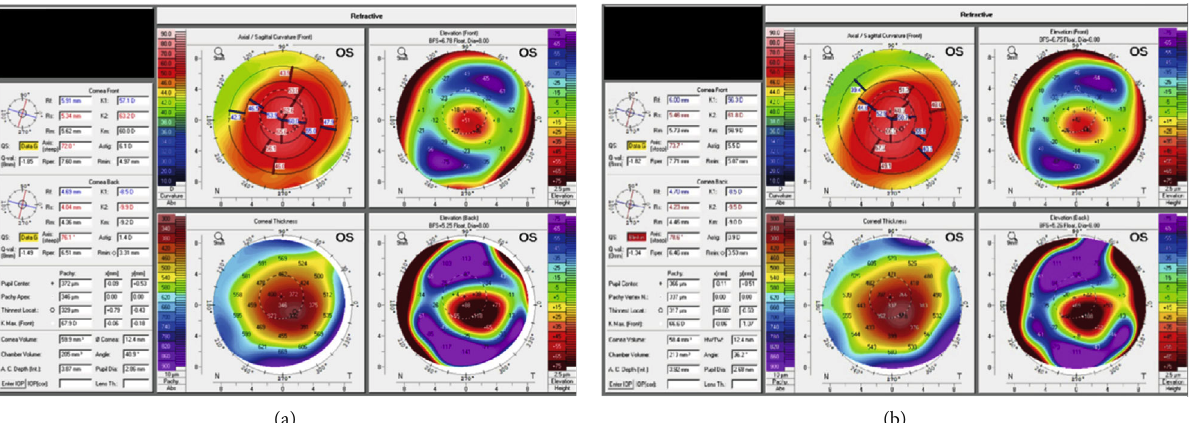
Figure 3: Tomography images of the left eye before (a) and after (b) cross-linking at the last follow-up 6 months postoperatively demonstrate the stability of keratoconus over the time course from before and after